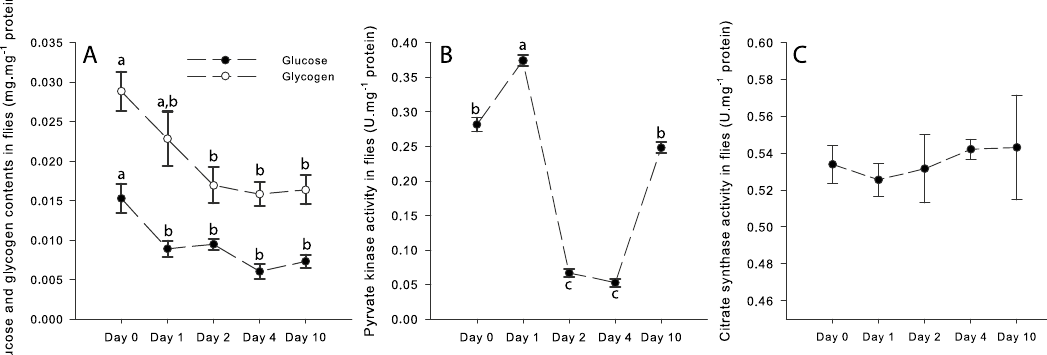
Figure 7. Effects of the high-fat diet (HFD) on ( A ) Glucose and Glycogen contents of flies, ( B ) Pyruvate kinase activity, and ( C ) Citrate synthase activity. Results are means ± s.e.m for each day of the exposure (N = 4–5 for glucose and glycogen contents; N = 6 for pyruvate kinase and citrate synthase activities) and have been analyzed using a one-way ANOVA followed by pairwise comparisons of the least-squares means using adjusted P -values (Tukey method). Dissimilar lowercase letters denote changes between days of exposure to a specifc diet, with each diferent letter(s) representing statistically significant differences ( P <